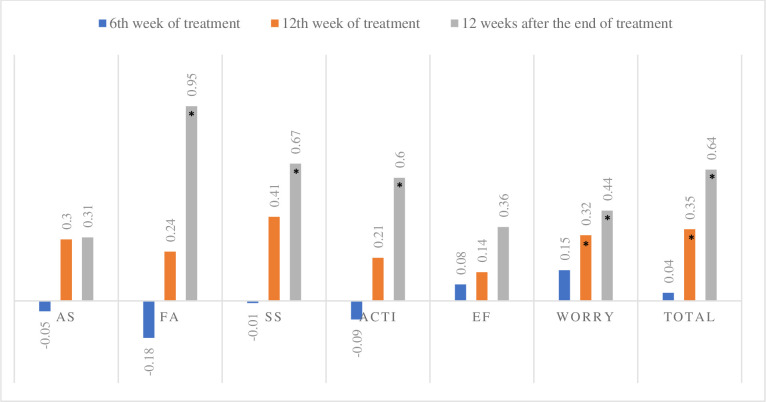
Difference of the mean score in relation to the CLDQ baseline.Analysis of Student t test to compare the means of week 6 of treatment, week 12 of treatment and 12 weeks after the end of treatment in relation to the baseline scores, * p <0.05. N = 105. AS, abdominal symptoms; FA, fatigue; SS, systemic symptoms; ACTI, activity; EF, emotional function.